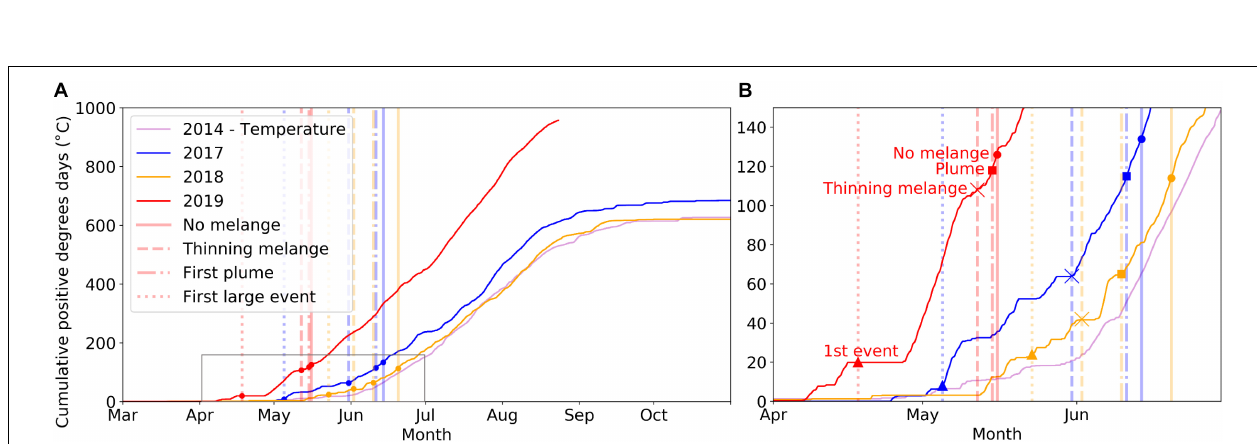
FIGURE 15 | (A) Cumulative positive degree days calculated with the meteo data from AWS1, AWS2 and Jar1 for the elevation of AWS2 (360 m a.s.l.). (B) Enlargement of the gray square in A. The first large calving event occurred shortly after the temperatures became positive, while the first subglacial meltwater plume appeared at the sea surface only after some weeks of positive